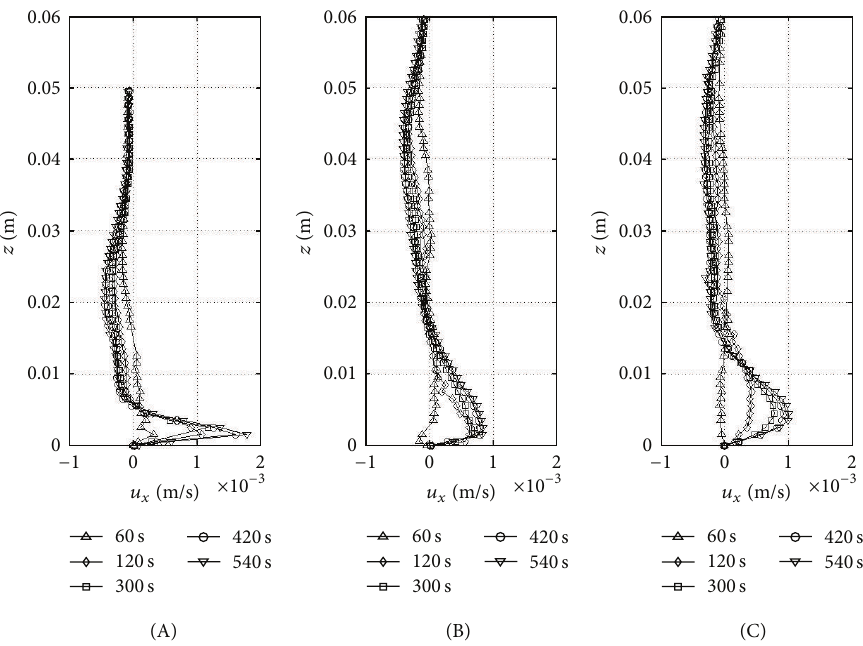
Figure 21: Velocity profiles A, B, and C at 5 time intervals from the beginning of experiment C1.